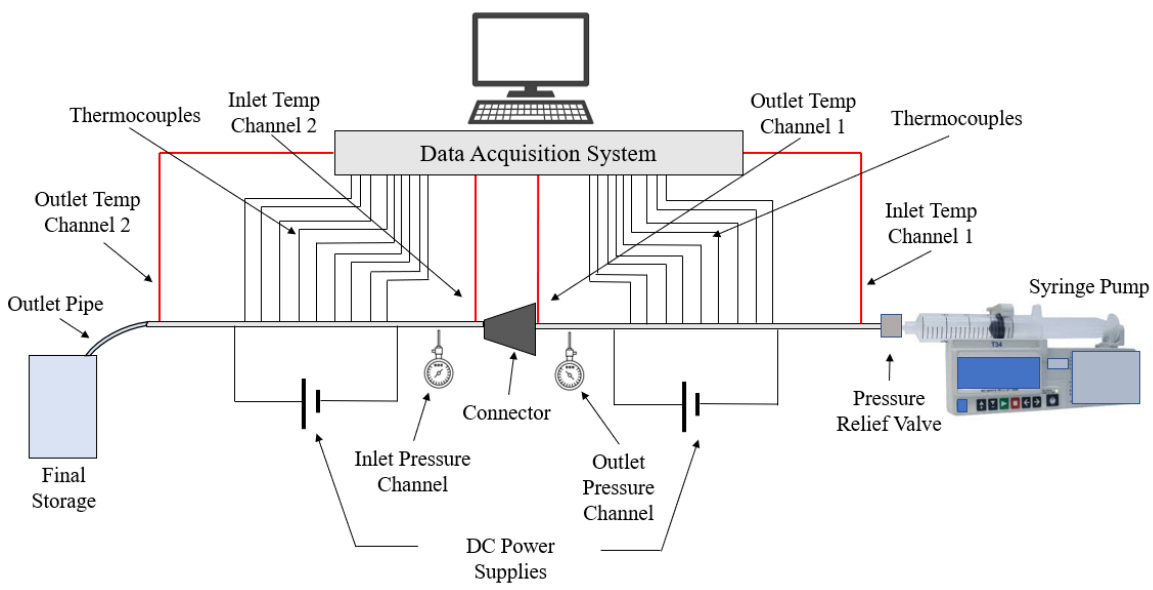
Figure 8. Setup used to measure the heat transfer coefficient along two microchannels connected in series.